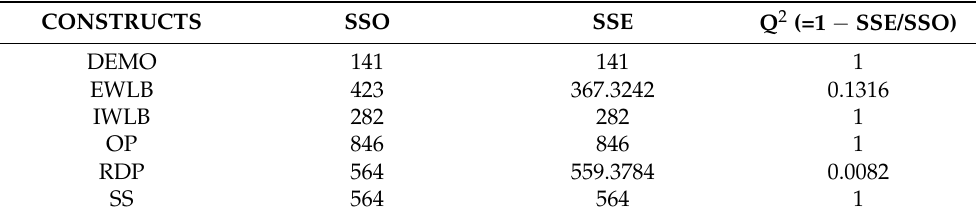
Table 8. Construct cross-validated redundancy (Q 2